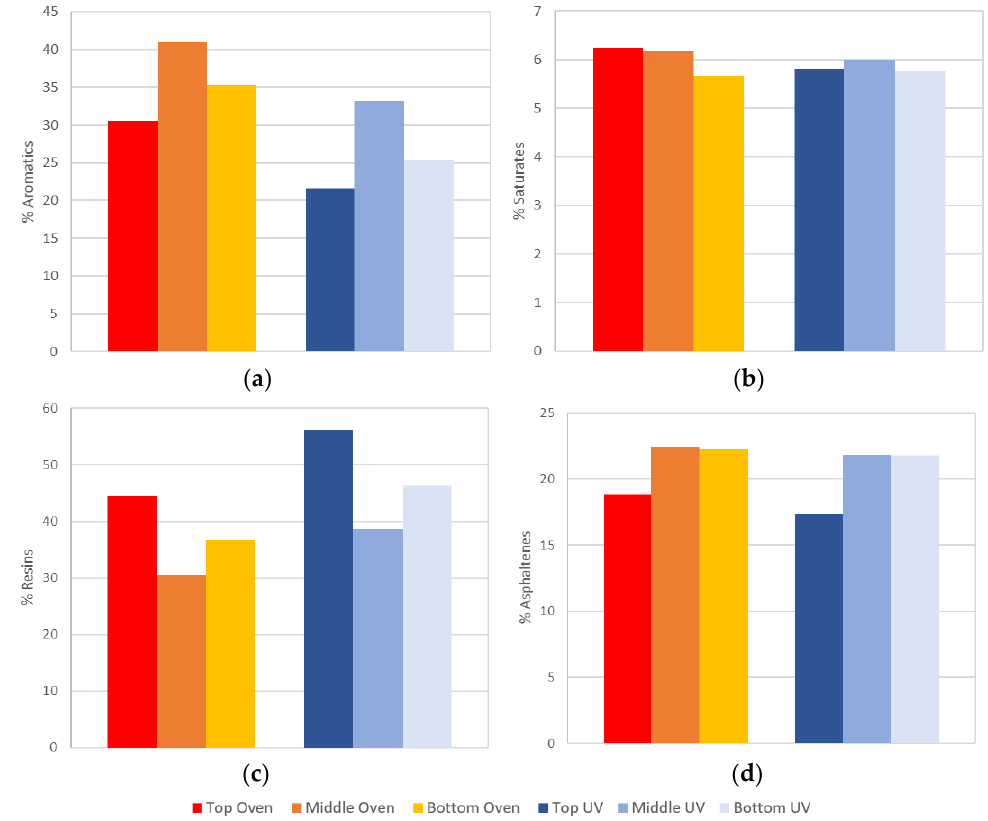
Figure 5. Comparison of SARA fraction values of extracted bitumen samples. ( a ) aromatics. ( b ) saturates. ( c ) resins. ( d ) asphaltenes.